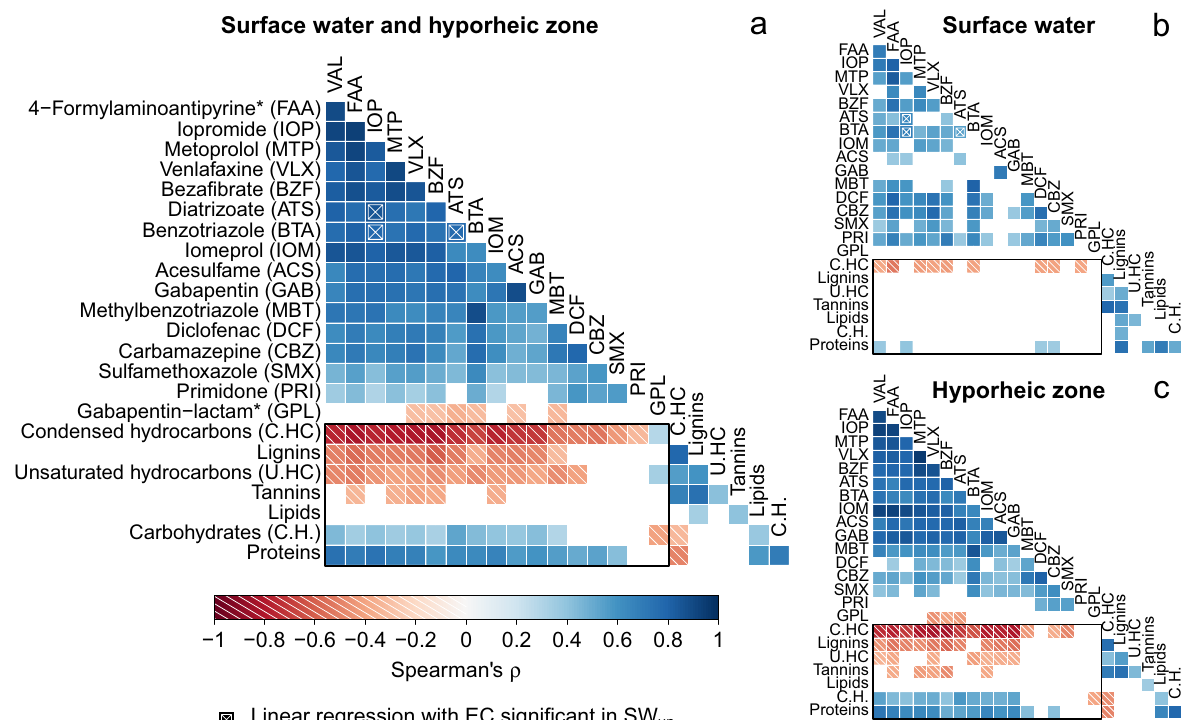
Figure 4. Correlation between TrOC concentrations and number of molecular formulas in DOM compound classes (black rectangle). Including ( a ) all data (SW up , SW down and PW down ), ( b ) only surface water data (SW up and SW down ) and ( c ) only data for the hyporheic zone at the downstream site (SW down and PW down ). Only significant correlations with p > 0.05 are shown. Correlations in SW up potentially due to collinearity with EC, which serves as a proxy for delayed substance transport, are marked with an X on top of the rectangle. * indicates transformation products , VAL =